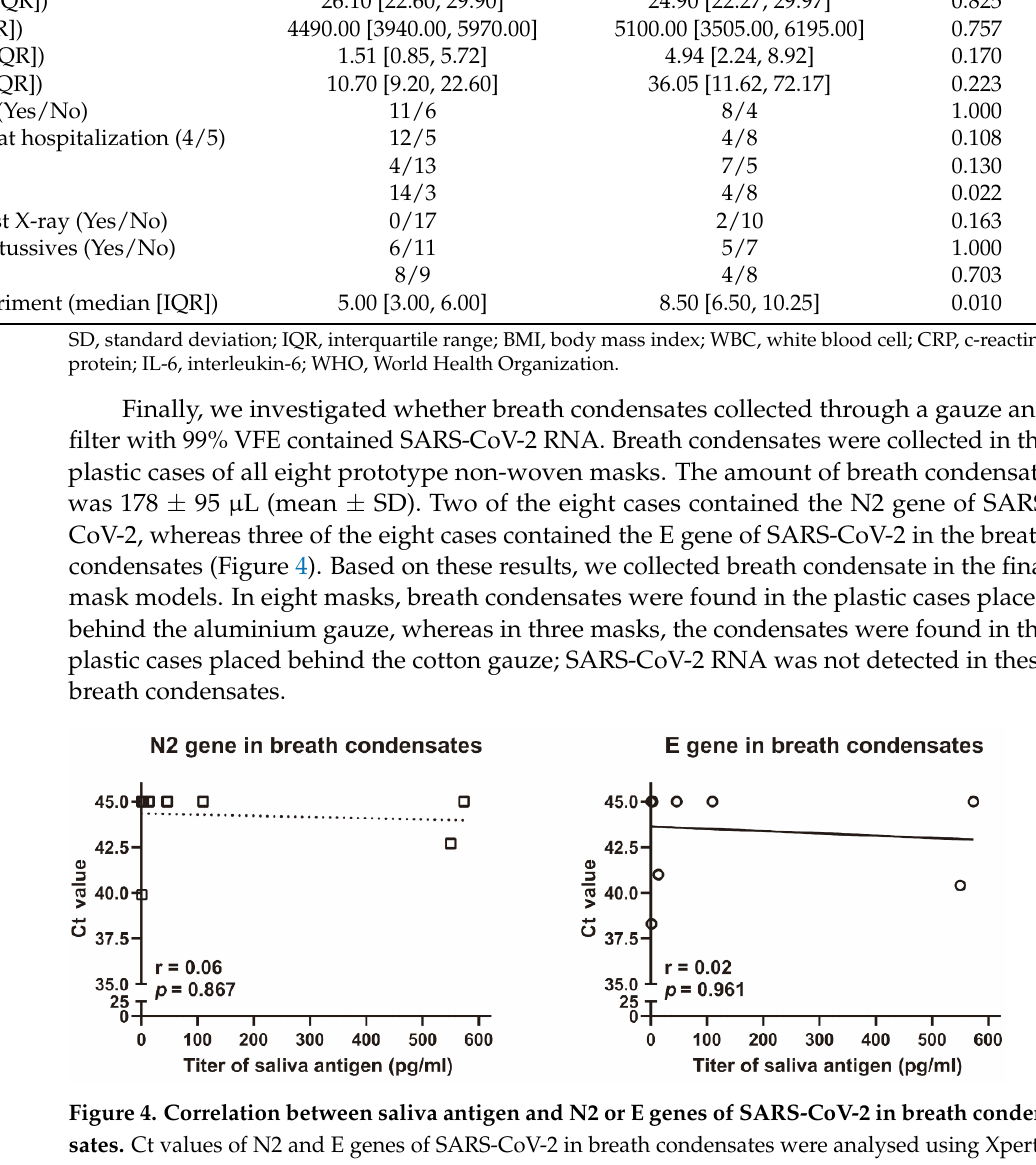
6 Table 1. Patient characteristics.